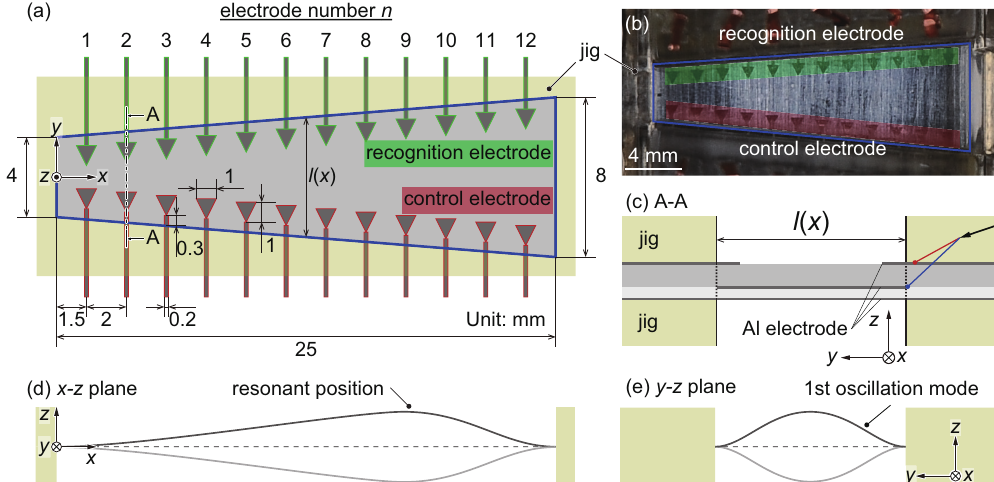
Figure 1. Artificial cochlear sensory epithelium fabricated in this study. ( a ) Schematic of the device. The piezoelectric membrane has a trapezoidal fixed boundary to mimic the shape of the basilar membrane. The device contains recognition electrodes to locally measure the electrical output, and control electrodes to locally oscillate the device via the inverse piezoelectric effect. ( b ) Photograph of the artificial cochlear sensory epithelium. ( c ) Side view of the membrane in the yz plane. The device is a bimorph membrane and consists of two polyvinylidene difluoride (PVDF) membranes with thicknesses of 80 and 40 µ m. The 80 µ m membrane contains deposited Al electrodes to measure electrical output and/or apply electrical stimuli. ( d ) Illustration of resonance in the xz plane. When a single tone is applied to the device, the resonance position is determined as the position with the maximum oscillation amplitude is observed. The resonance position varies depending on the frequency, providing a frequency selectivity function for the trapezoidal membrane. ( e ) Illustration of the oscillation mode in the yz plane. The local resonance frequency is dependent on the length in the y -direction, and the local vibration is described by the first oscillation mode.